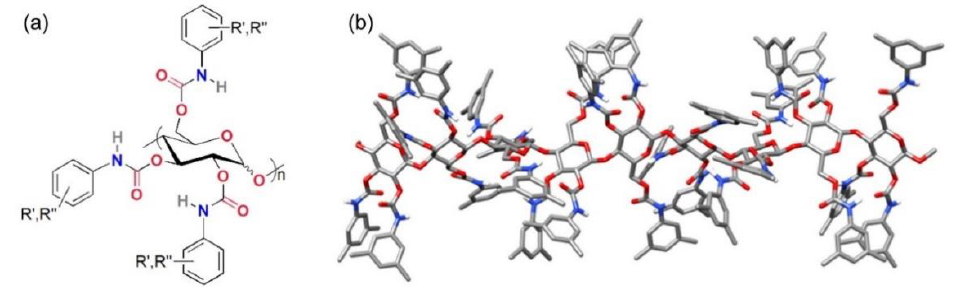
Figure 4. Drawing of polysaccharide carbamate-based selectors ( a ); three-dimensional (3D) tube structure of cellulose tris (3,5-dimethylphenylcarbamate) ( b ).